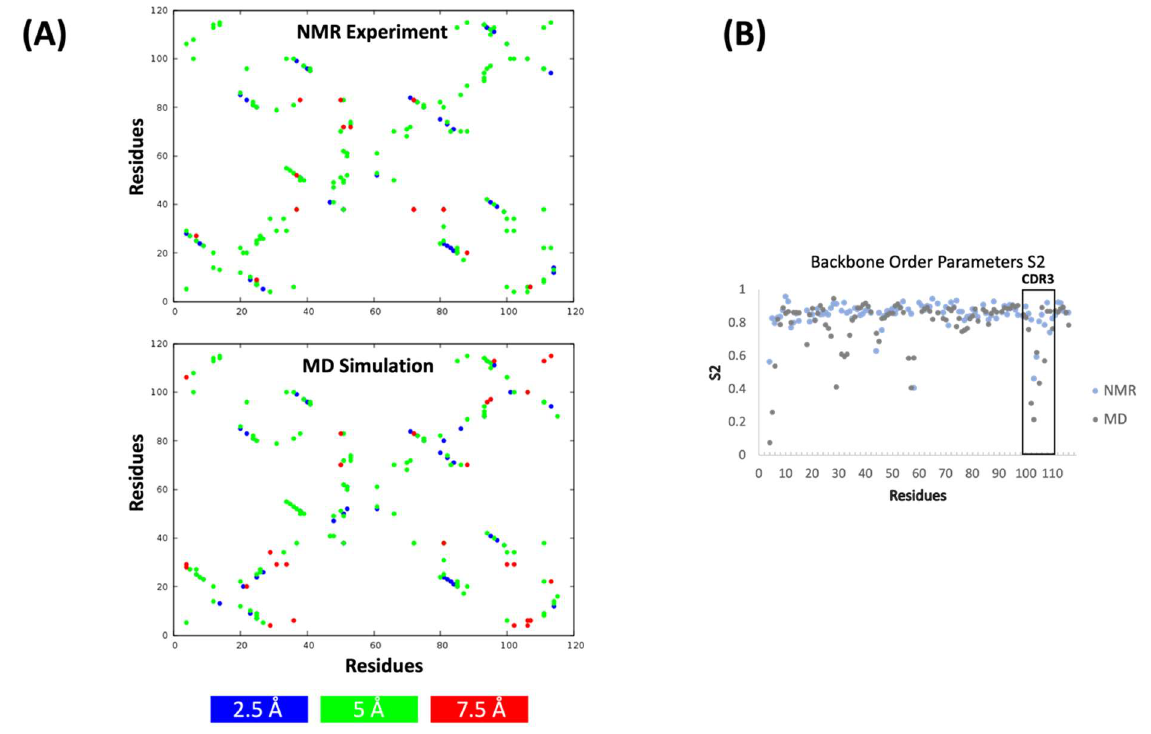
Figure 4. Calculated and experimentally measured NOE distances and order parameters (S 2 ) for the anti-GFP nanobody. ( A ) Experimental upper NOE limits are shown on top, calculated NOE limits are shown at the bottom. ( B ) Experimental S 2 and calculated S 2 are colored in light-blue and grey, respectively.